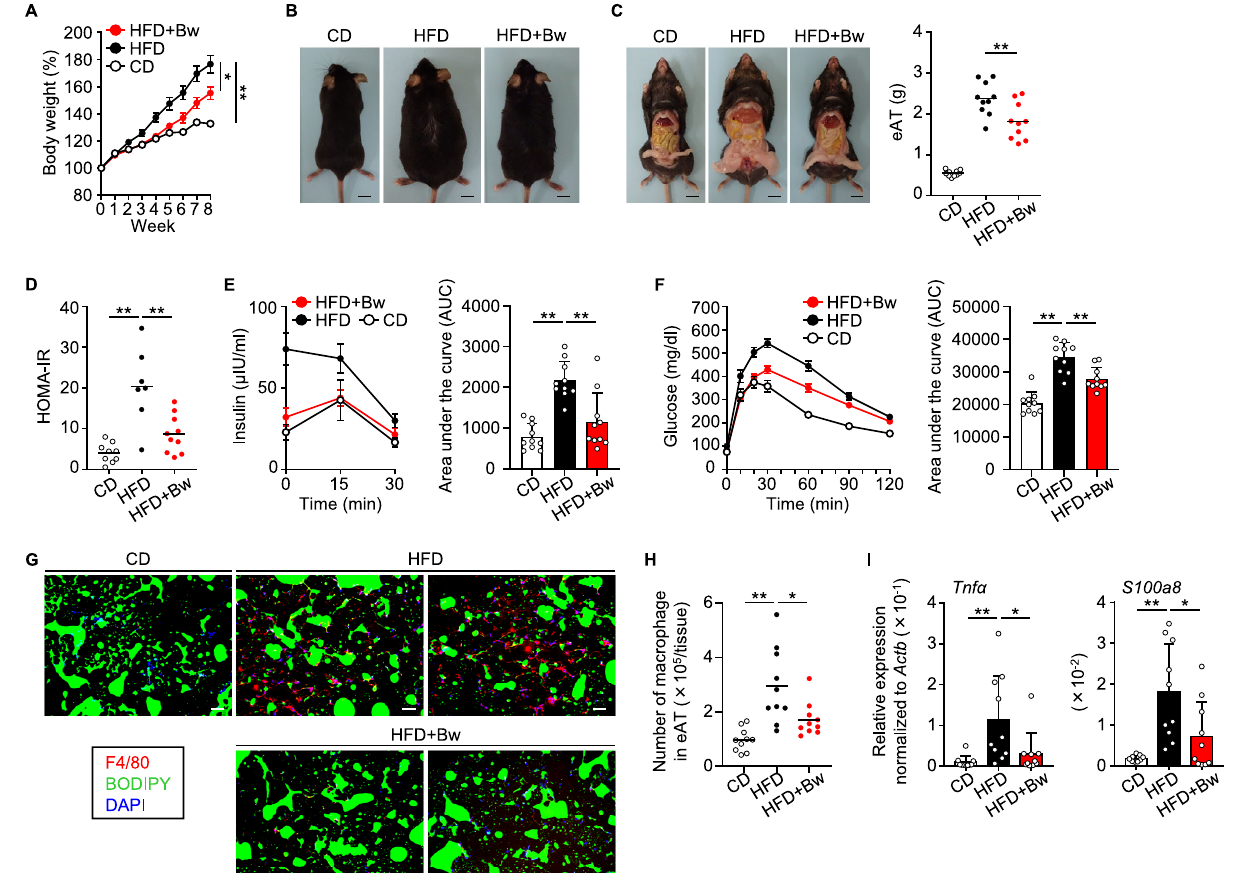
Fig. 2 | High-fat diet (HFD)-induced obesity and diabetes were ameliorated by oral administration of Blautia wexlerae to mice. A Mice were maintained on standard chow (control diet, CD) or HFD without or with oral administration of B. wexlerae (Bw) three times each week and were weighed weekly. Data are repre- sentative of at least three independent experiments ( n =5, mean ± 1SD). * P =0.0105;** P =0.0005(two-wayANOVA). B Photographsof representativemice. C Photographs of representative mice and weight of epididymal adipose tissue (eAT). Data are combined from two independent experiments ( n =10, mean). ** P =0.0039 (one-way ANOVA). D HOMA-IR, an indicator of insulin resistance, calculated as ‘ glucose (mg/dl) × insulin ( µ U/ml)/405 ’ . Data are combined from two independent experiments without hemolytic samples ( n =7 – 10, mean). ** P